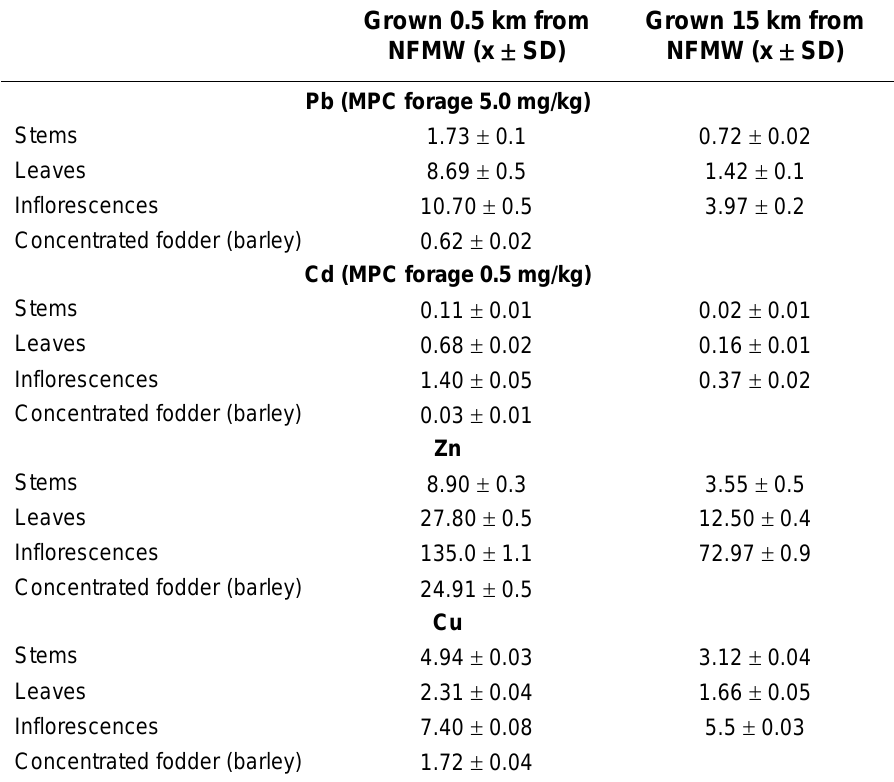
Content of Pb, Cd, Zn, and Cu (mg/kg) in R apeseed in the “ B lossoming” Stage Grown 0.5 km